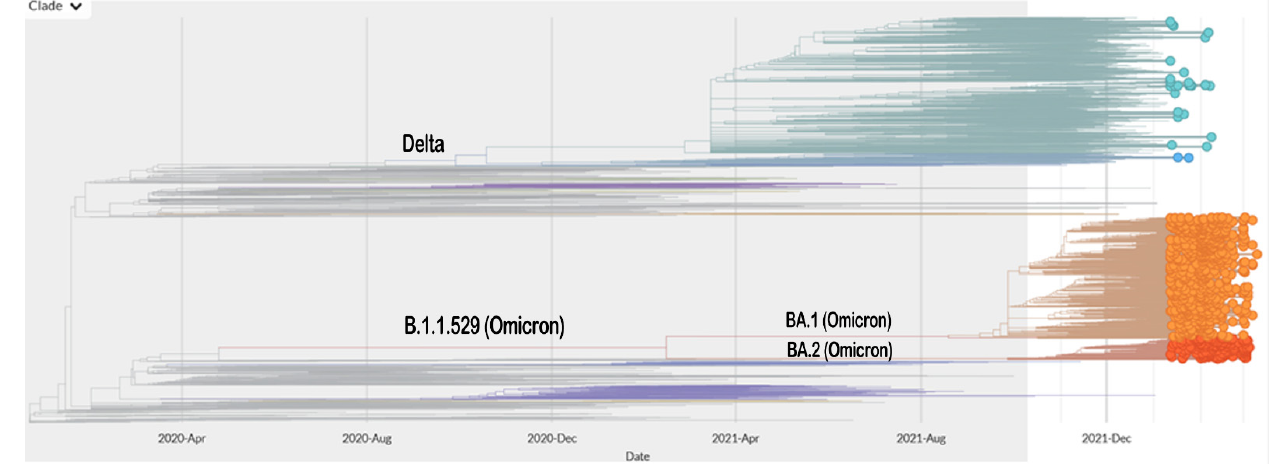
Figure 1. Phylogenetic tree of SARS-CoV-2 variants showing the position of the Delta and Omicron variants (https://nextstrain.org/ncov/gisaid/global?branchLabel=emerging_lineage&dmin=2022-01-12; accessed on 12 March 2022).